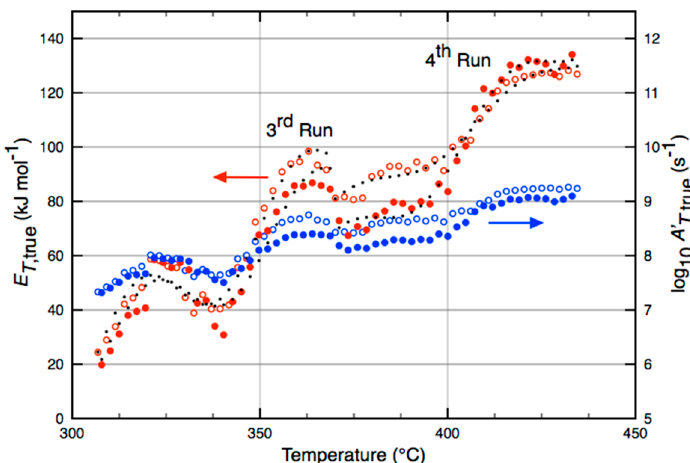
Figure 5. Apparent activation energies, E T ,true (red circles) and prefactors, log plotted against temperature for the evolution of methacrolein during temperature-programmed oxidation of isobutane over copper(II) phosphomolybdate (Cu 1.5 PMo 12 O 40 ) for the 3 rd (unfilled circles) Catalysts 2016 , 6 , 137 8 of 15 and 4 th runs (filled circles). Black dots are simulated activation energy oscillations.